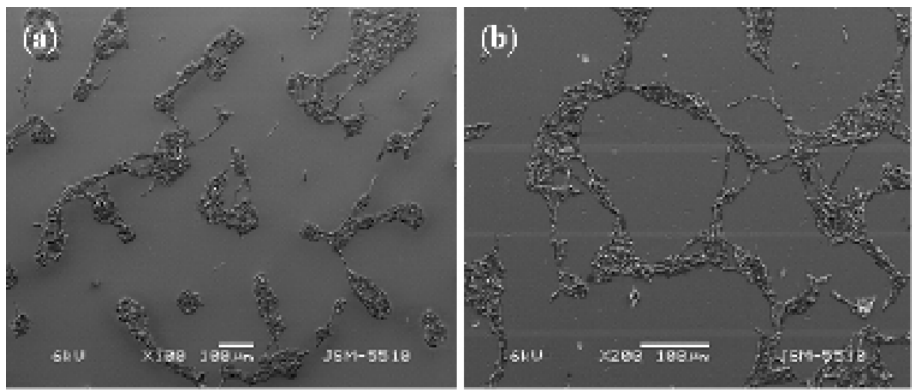
Figure 3. SEM images of Tr. cutaneum R57 immobilized onto PVA/TEOS matrices: (a) 3 wt% TEOS, and (b) 10 wt% TEOS.